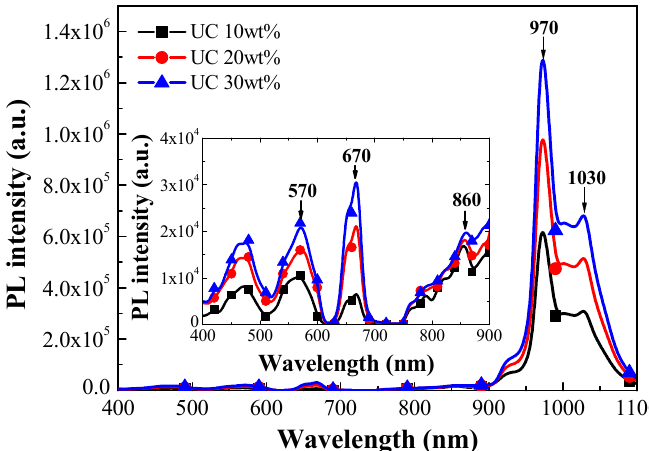
Figure 4. Energy-dispersive X-ray spectroscopy (EDS) spectrum obtained from SiO 2 coating containing Yb/Er-doped yttrium oxide-based phosphors (YF 3 :Yb 3+ /Er 3+ ).